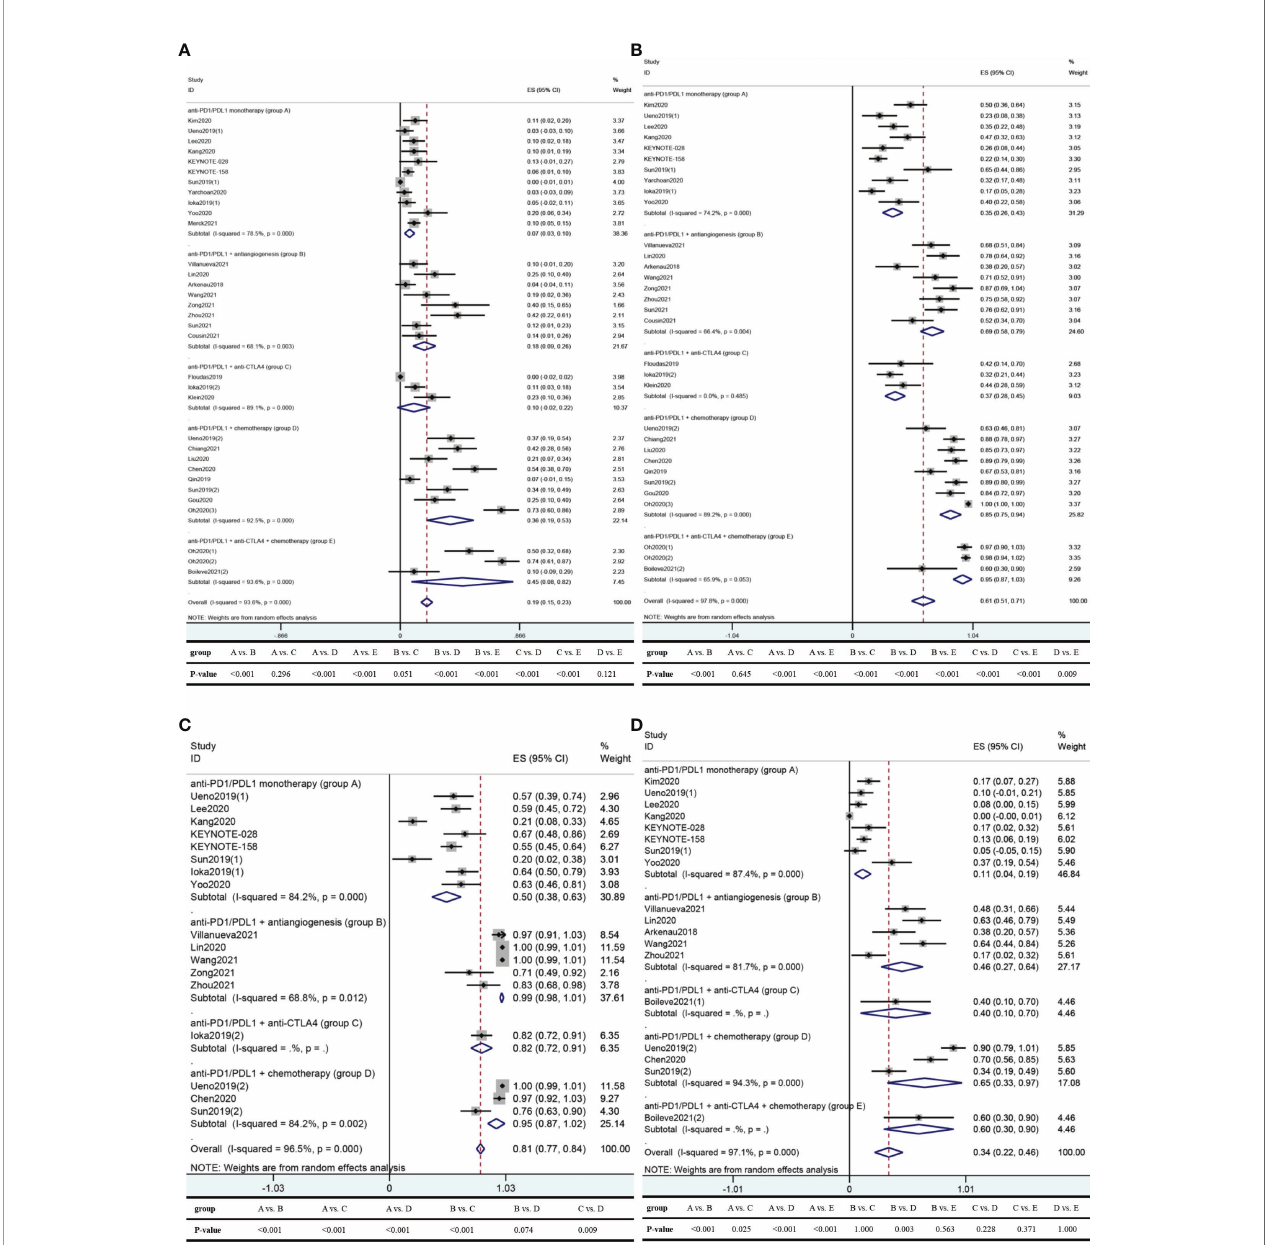
FIGURE 4 | Pooled results of ORR, DCR, any-grade AEs, and grade 3 – 4 AEs in total and by medication regimen subgroup. (A) ORR; (B) DCR; (C) any-grade AEs; (D) grade 3 – 4 AEs. Five studies had more than one subgroup of interest. Speci fi cally, patients were allocated to the nivolumab group [Ueno2019(1)] or the nivolumab/GemCis group [Ueno2019(2)] in the Ueno2019 study; the PD1 inhibitor monotherapy group [Sun2019(1)] or the PD1 inhibitor plus chemotherapy group [Sun2019(2)] in the Sun2019 study; the durvalumab group [Ioka2019(1)] or the durvalumab/tremelimumab group [Ioka2019(2)] in the Ioka2019 study; the biomarker group [receiving durvalumab/tremelimumab with GemCis, Oh2020(1)], the durvalumab/tremelimumab with GemCis group [Oh2020(2)], or the durvalumab with GemCis group [Oh2020(3)] in the Oh2020 study; the durvalumab/tremelimumab group [Boileve2021(1)] or the durvalumab/tremelimumab with paclitaxel group [Boileve2021(2)] in the Boileve2021 study. Note: Heterogeneity across studies was evaluated by the Cochran Q chi-square test and I 2 statistic, with P < 0.1 for the Q test deemed to have high heterogeneity and I 2 >50% regarded as an indicator of moderate-to-high heterogeneity. If separate verdicts from the Q test and I 2 statistic were at opposite poles, we would give priority to the conclusion from the I 2 statistic since the former is proverbially underpowered to detect heterogeneity. Differences between groups were tested by the chi-square test using IBM SPSS Statistics 22.0, with two-sided P -value <0.05 considered signi fi cant. ORR, objective response rate; DCR, disease control rate; AEs, adverse events; ES, effect size; CI, con fi dence interval; PD1, programmed cell death protein 1; PDL1, programmed cell death ligand 1; CTLA4, cytotoxic T lymphocyte antigen 4; GemCis, gemcitabine +